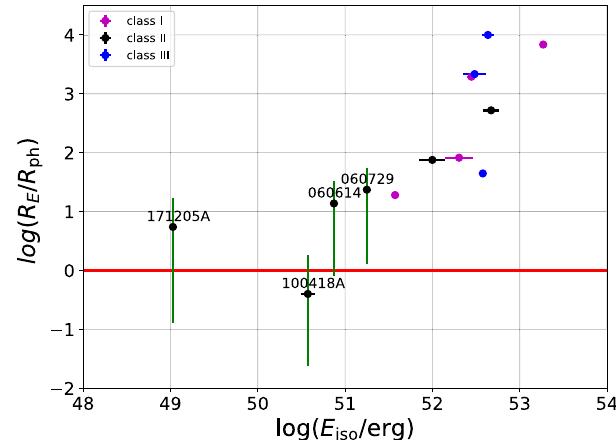
Fig. 3 | The initial GRB jet Lorentz factor, Γ i and the ambient density, A ⋆ . They are marked by lines, each corresponds to a different GRB. From top to bottom: GRBs 080607, 110213A, 060714, 080310, 061121, 060605, 130831A, 091029,